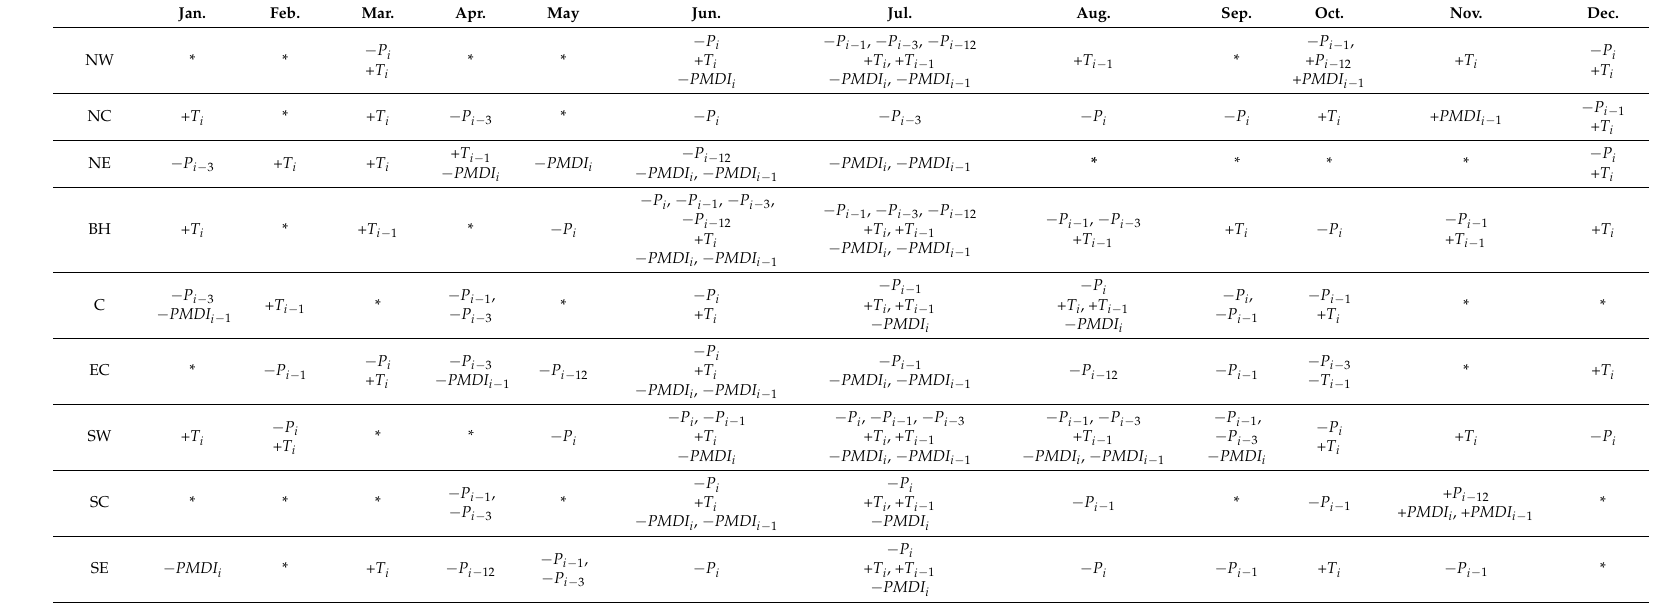
Table 2. Significant ( p < 0.05) Spearman’s rank order correlations for wildfire area burned and climate variable pairs for each month for each South Dakota Climate Division. Positive (negative) values for PMDI indicate significant rank correlations between abnormally wet (dry) periods and area burned, positive (negative) values of temperature (T) indicate significant rank correlations between above (below) average temperatures and area burned, and positive (negative) values of precipitation (P) indicate significant rank correlations between precipitation deficits (surpluses) and area burned. Asterisks (*) imply no significant correlation. See text and Table 1 for climate variable and subscript time-lag